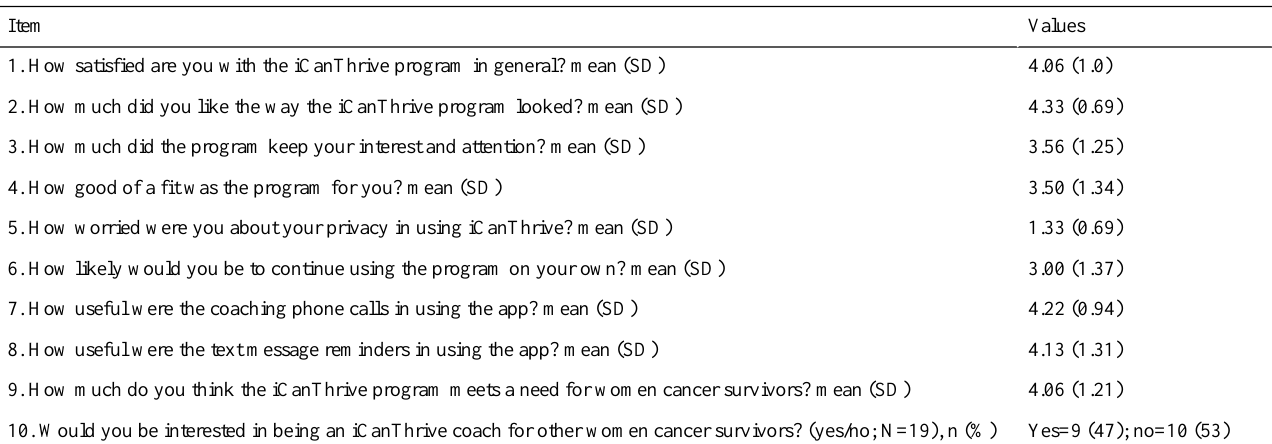
Table 2. Feedback items (scale ranged from 1 to 5) and descriptive statistics (n=19).